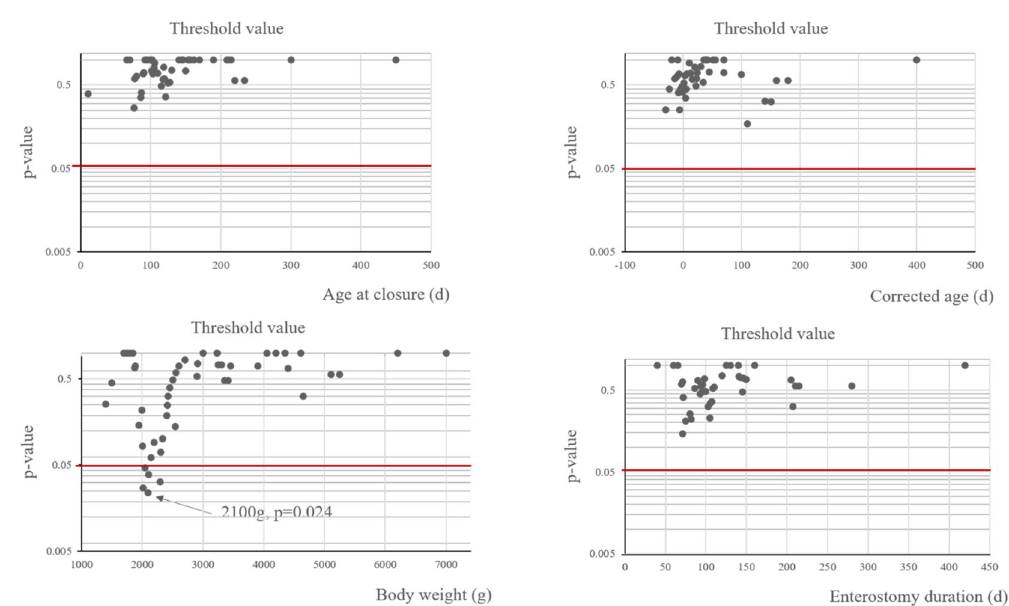
Figure 3. Results of minimum p-value analysis with respect to age, corrected age, body weight at enterostomy closure (EC), and enterostomy duration for EC-related complication. Only body weight at EC showed significant cut-off values. Among them, 2100 g yielded the minimum p -value in the Chi-squared test. with an enterostomy duration < 10 weeks had a higher morbidity rate than those who underwent EC later with an enterostomy duration > 10 weeks 10 . Bethell G et al . divided patients according to complications or no compli- cations 14 and reported that 24 patients with complications weighed less than 34 patients without complications